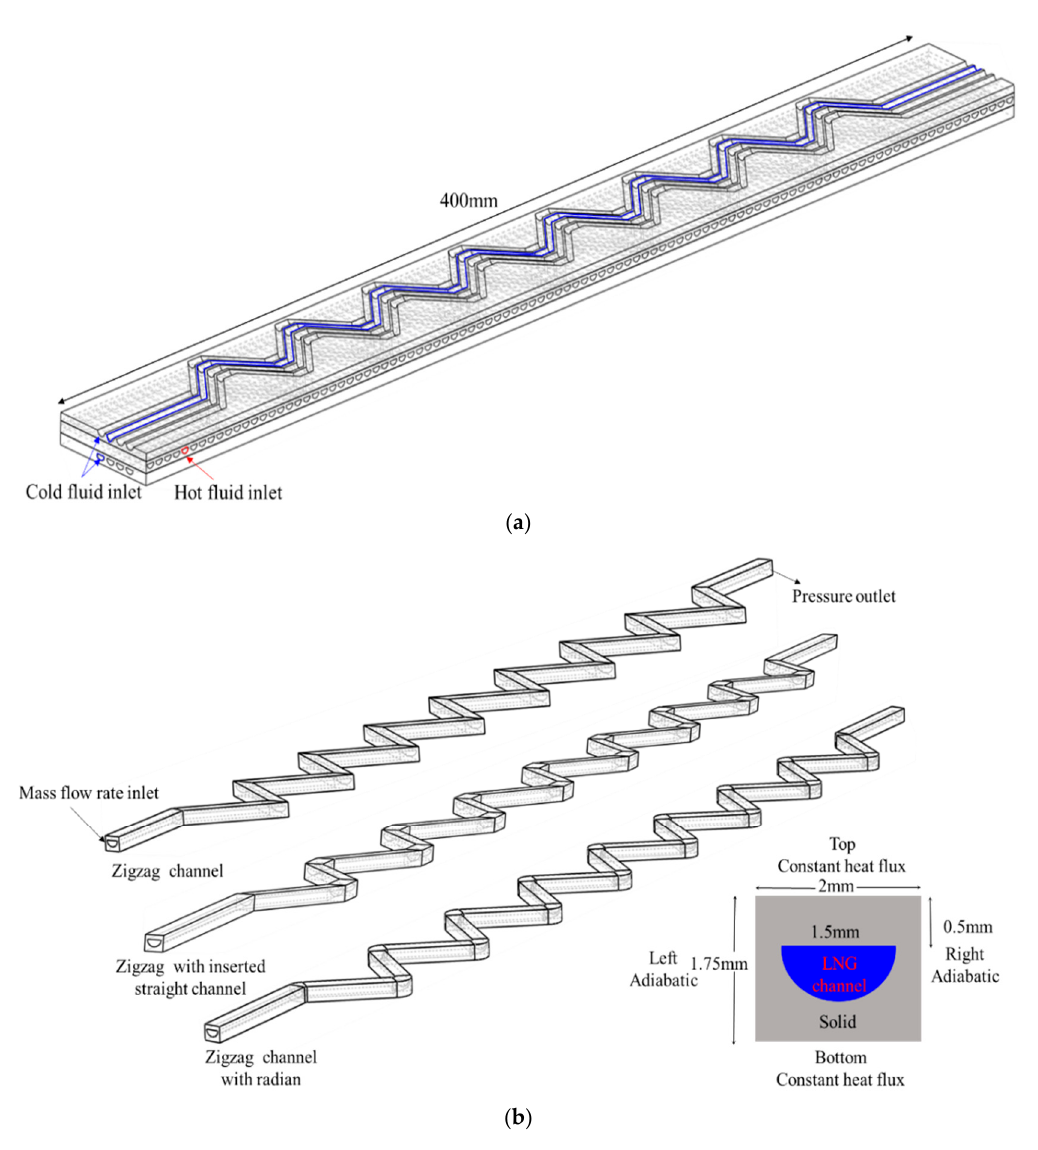
Figure 1. The simplified numerical model: ( a ) the core of PCHE; ( b ) the shape of a single channel and boundary